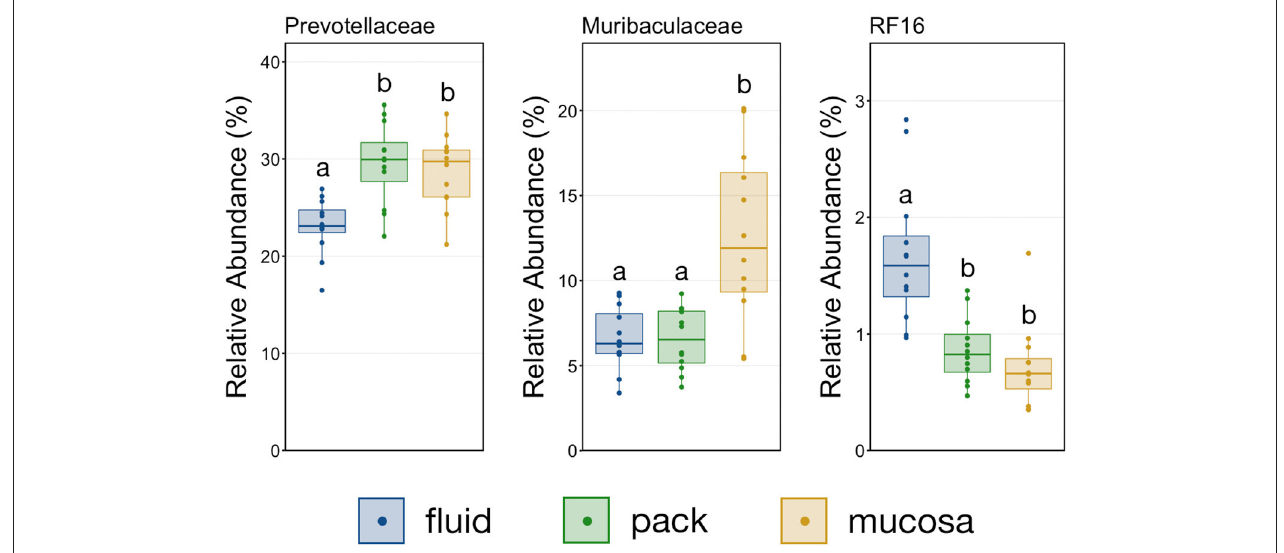
FIGURE 6 | Boxplot demonstrating the relative abundances of the three families from the phylum Bacteroidetes discriminant of a ruminal micro-environments. Points represent individual animals, and the horizontal line in each boxplot represents the median relative abundance. Significant differences between the relative abundances of each family are illustrated by different letters (Pairwise Wilcoxon rank-sum with Benjamini-Hochberg correction, p < 0.05, n = 12).